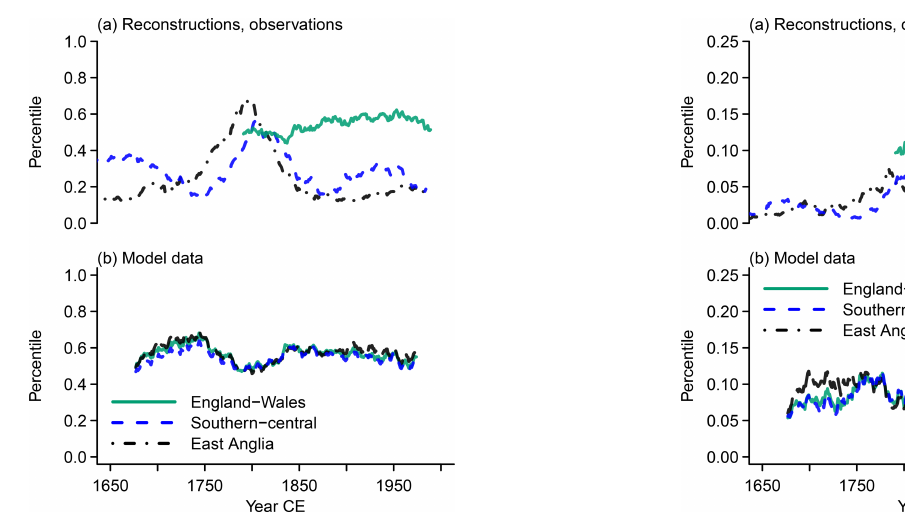
Figure 8. Visualization of how percentile values change over win- dows. We show what the 50th percentile MAMJJ precipitation amount for a reference window represents over time for England– Wales (green solid lines), southern–central England (blue dashed lines), and East Anglia (black dash-dotted lines) in (a) reconstruc- tions, observations, and (b) simulations. The reference window is centered on 1815CE.